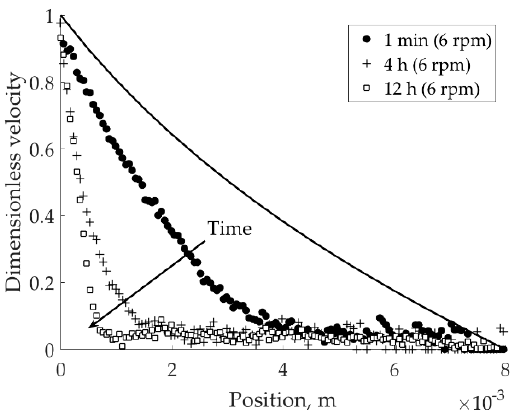
Figure 6. Recovery of shear banding under the load in the pH 4 in 1 × 10 − 2 M KNO 3 suspension, after agitation at 27 rpm.